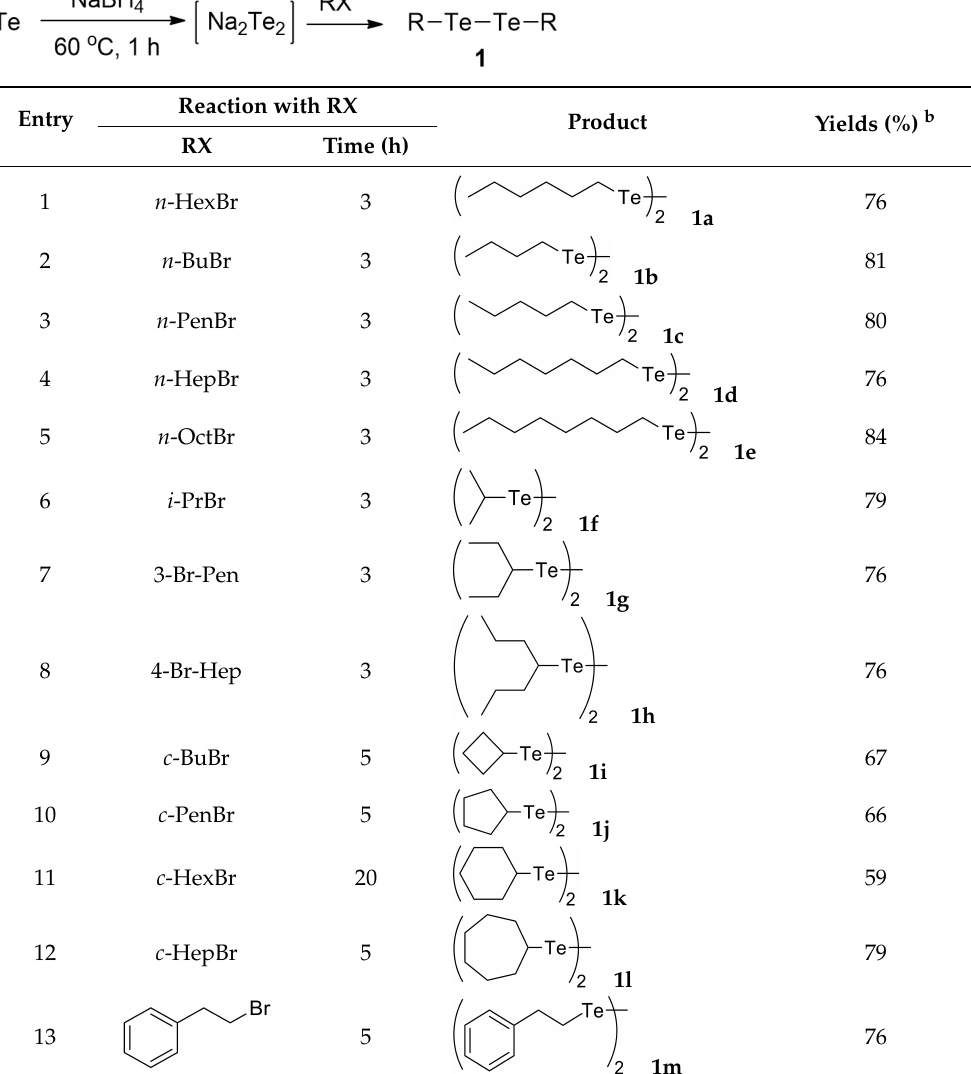
Table 2. Syntheses of dialkyl ditellurides 1 a